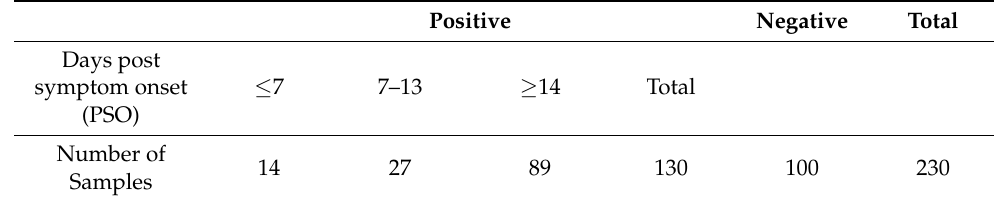
Table 1. Sample size and timing of specimen collection for the clinical evaluation.